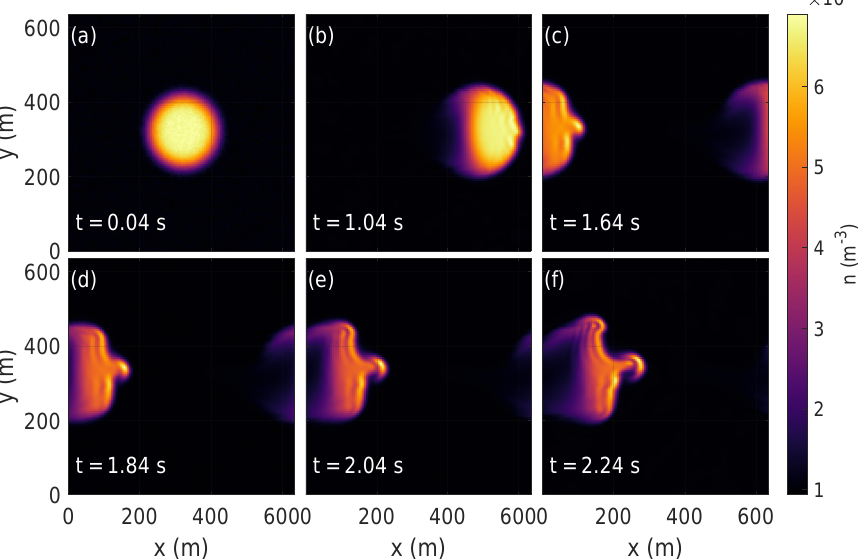
Figure 3. Density color plots of the 2D simulations showing the evolution of a plasma enhancement cloud in a collisional regime. Panel ( a ) shows the initial cloud. Panel ( b ) shows the cloud moving to the right. A finger-like structure extends from the center of the cloud, as seen in Panels ( c , d ). In Panels ( e , f ), a GDI-induced bifurcation begins to form as the tip of the finger-like structure curls into itself into a secondary KHI indicated by the “mushroom heads”.